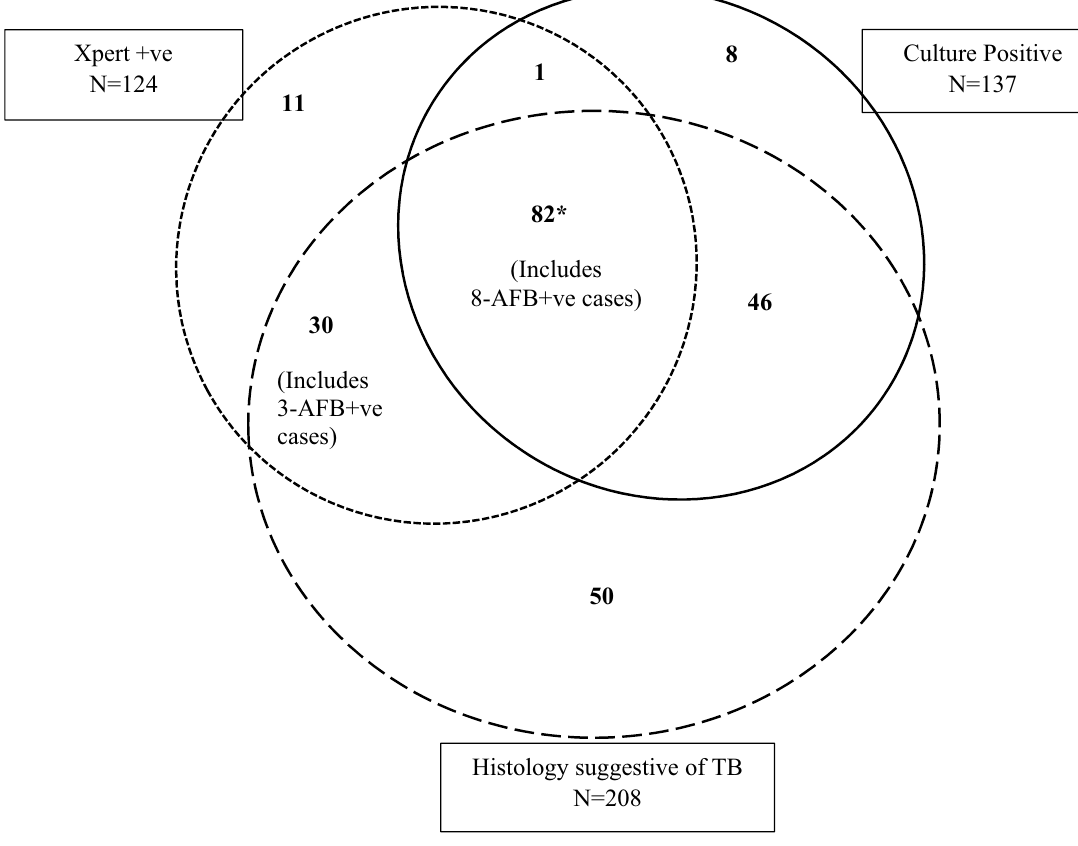
Figure 2. Venn diagram showing Xpert MTB/RIF, culture, and histology results of 228 tuberculous lymphadenitis patients diagnosed using composite reference standard.